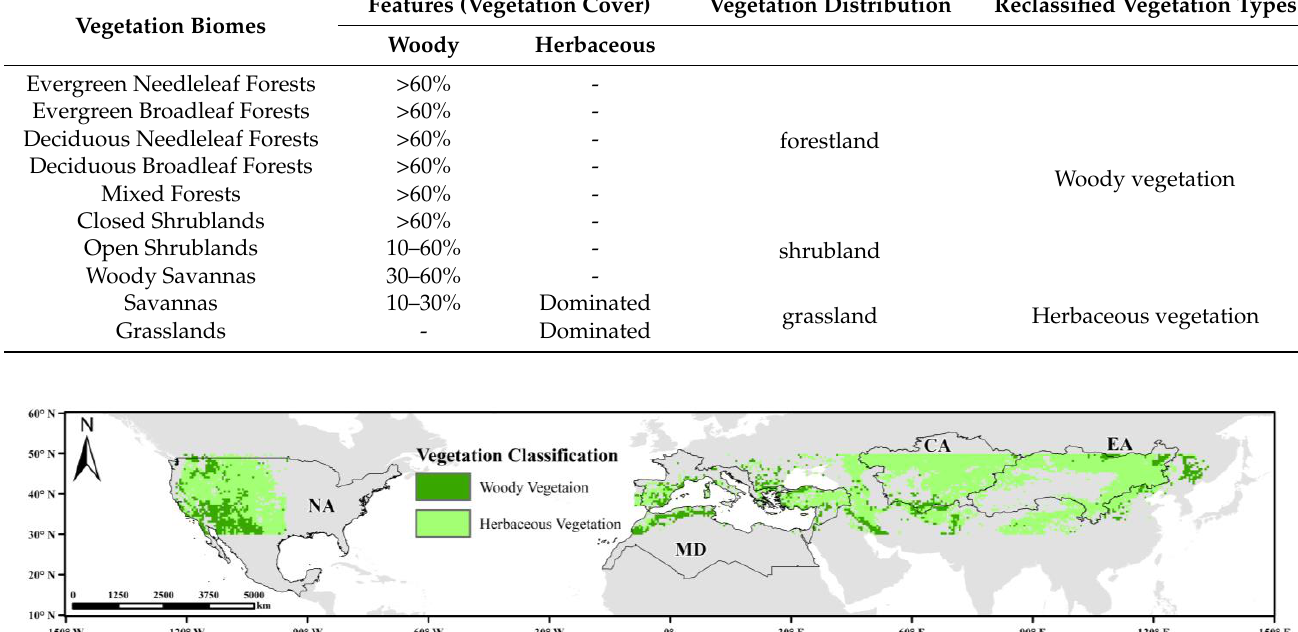
Table A1. Vegetation classification in the study area.